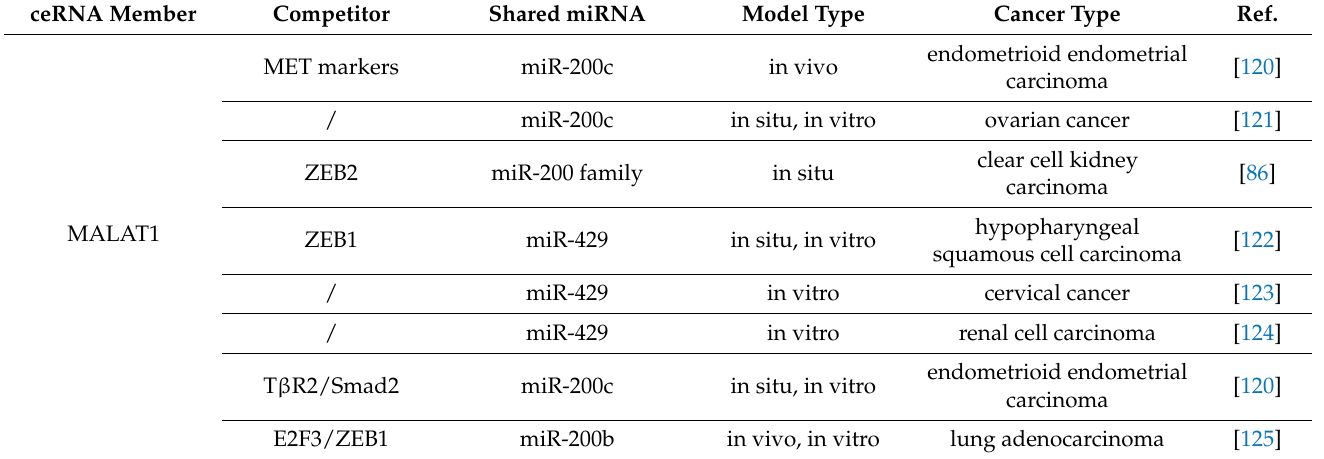
Table 2. Members of lncRNA-miRNA-mRNA ceRNA network type for miRNAs in subgroup II. ceRNA